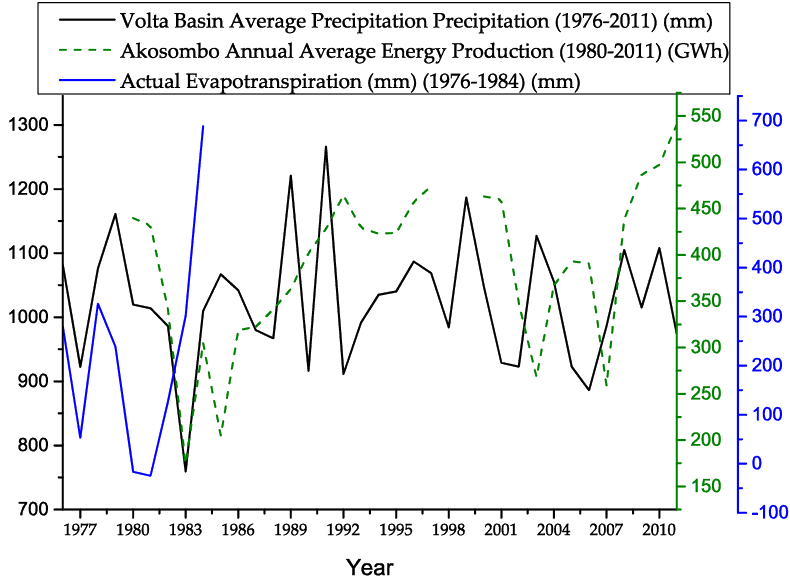
Figure 10. Plot of average precipitation, plant discharge, water level, and energy production at Akosombo dam. The average precipitation of the Volta Basin was estimated using the Thiessen Method.